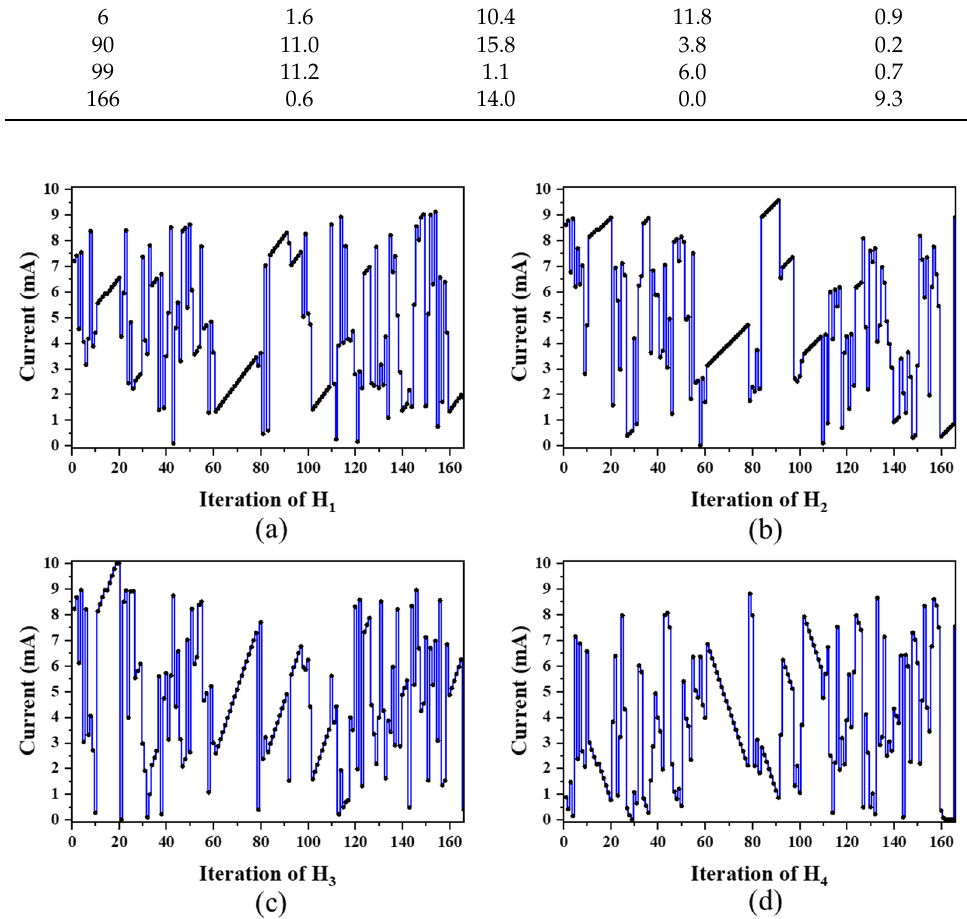
Figure 9. ( a – d ) The current configurations of H 1 to H 4 in the